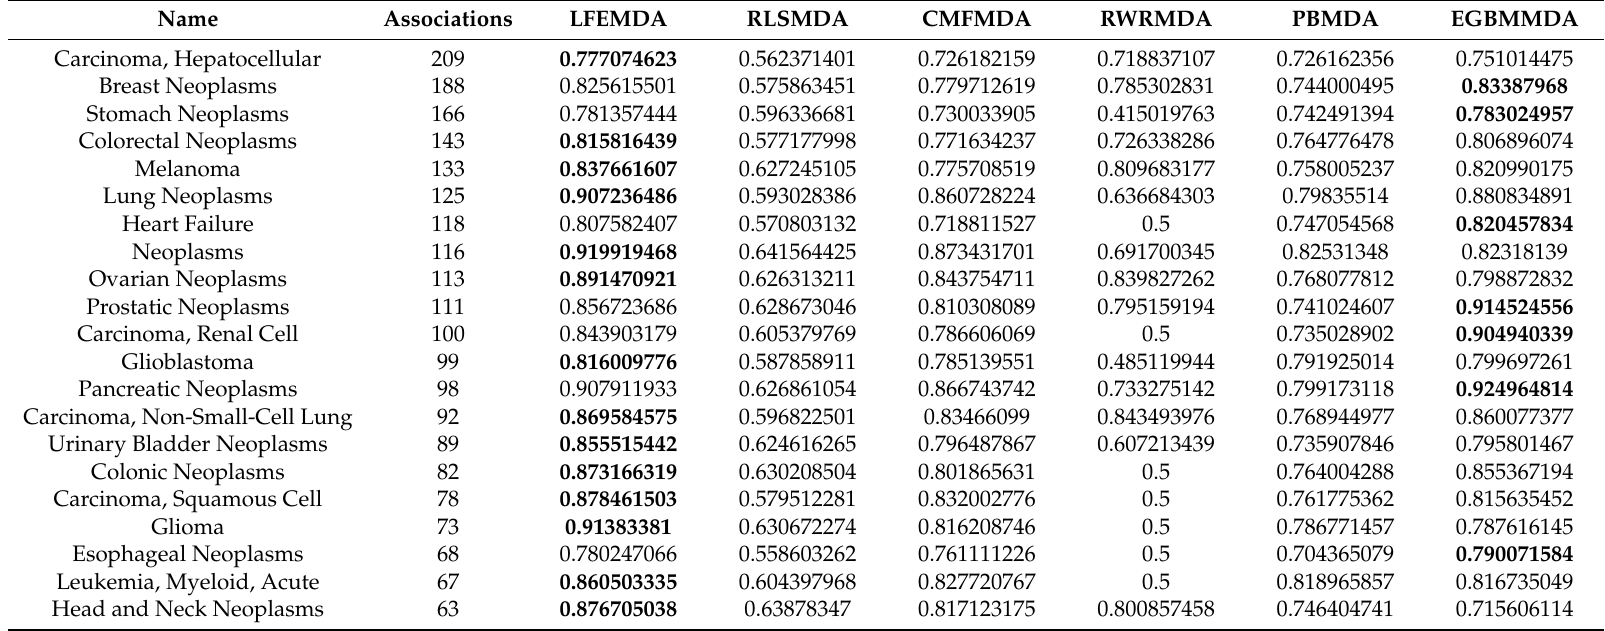
Table 1. The AUC results of high-association diseases under different